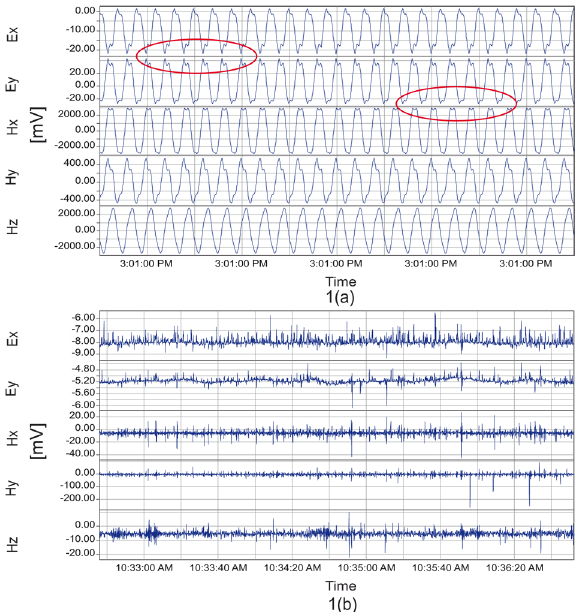
Figure 1. Time series of site K11 of Koyna profile contaminated with cultural noise. (a) Time series obtained from 4 KHz sampling fre- quency is affected by powerline noise (50 Hz), which shows the peak distortion (red indicator) prominently. (b) Time series from 32 Hz sampling frequency contaminated with heavy cultural